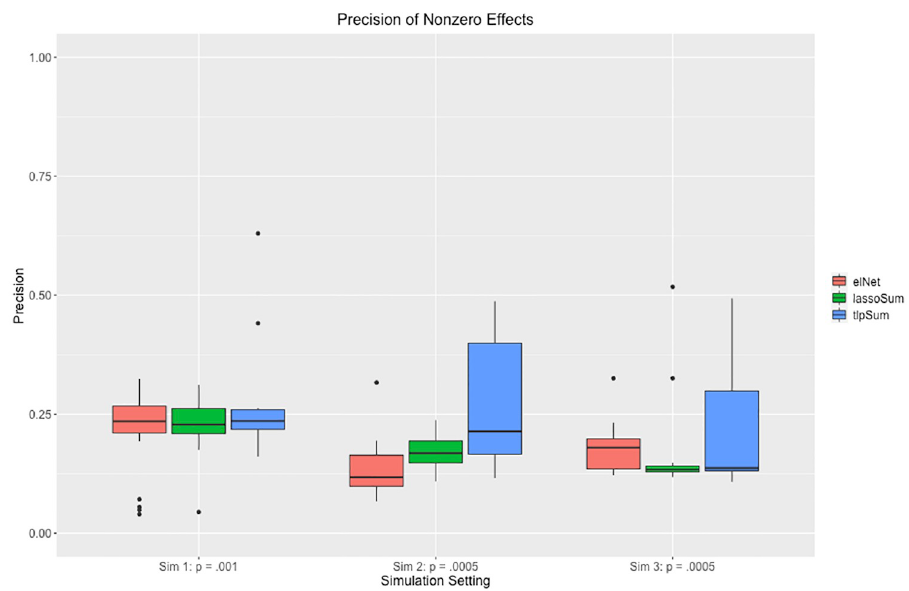
Fig 8. Precision of estimated nonzero effect sizes for the penalized regression methods applied to the three sparse simulation settings.